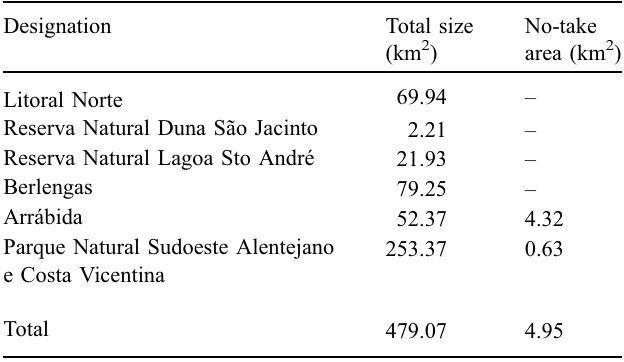
Table 1. Current marine protected areas implemented in mainland Portugal and some of their characteristics.